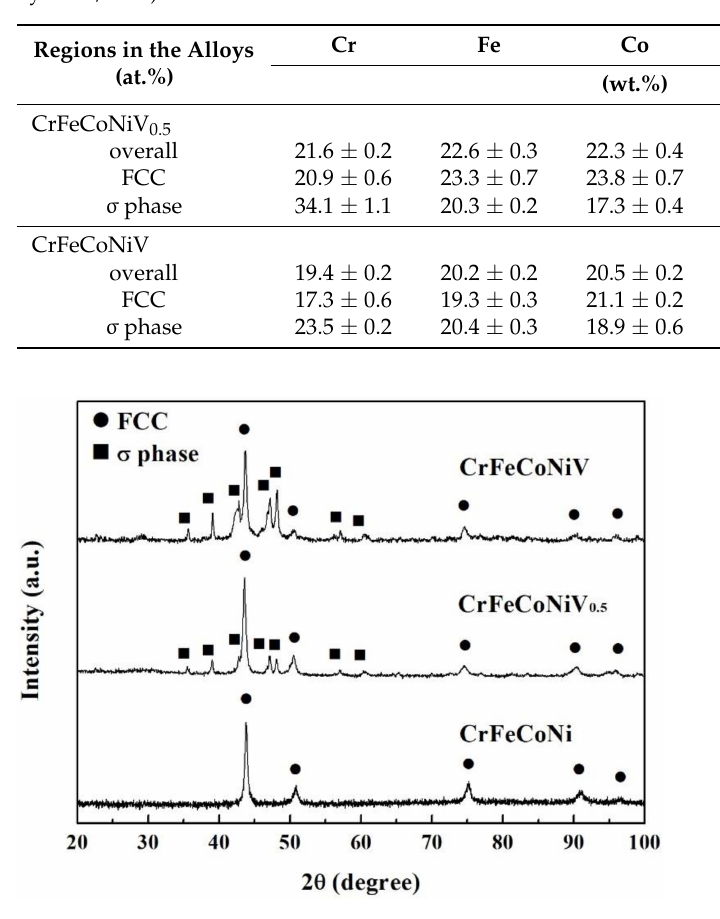
Figure 2. XRD patterns of as-cast CrFeCoNiV x